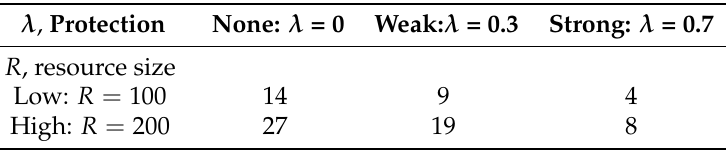
Table 2. Theoretical predictions on group fighting